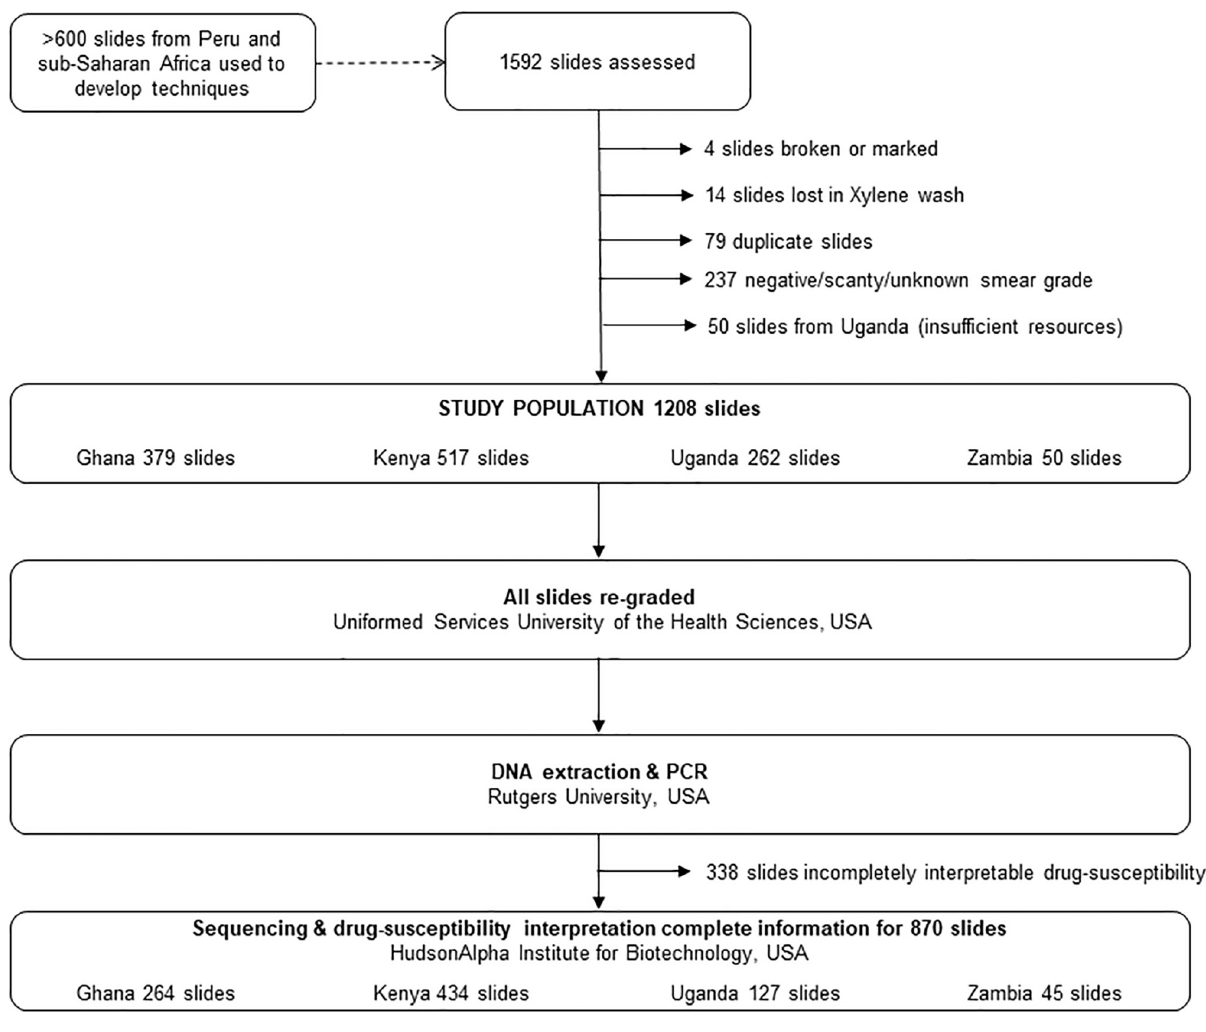
Fig 1. Flow diagram schematic of study sample population and